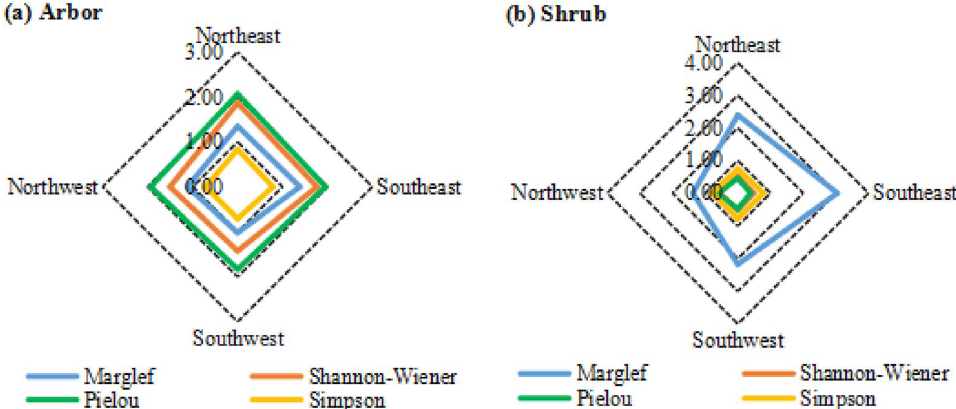
Figure 4. Diversity distribution of different directions outside tiankeng.